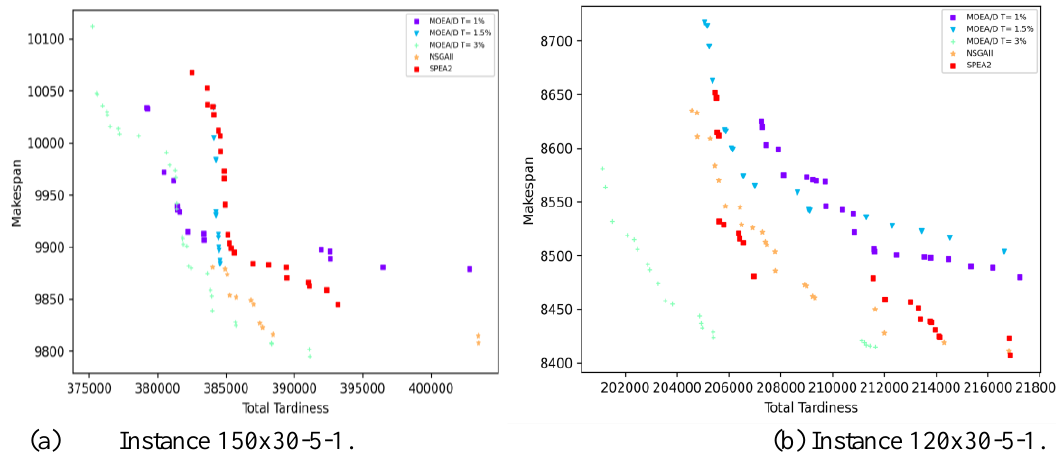
Figure 4 . Sample Pareto fronts computed by MOEA/Ds and baseline NSGAII and SPEA2 for representative